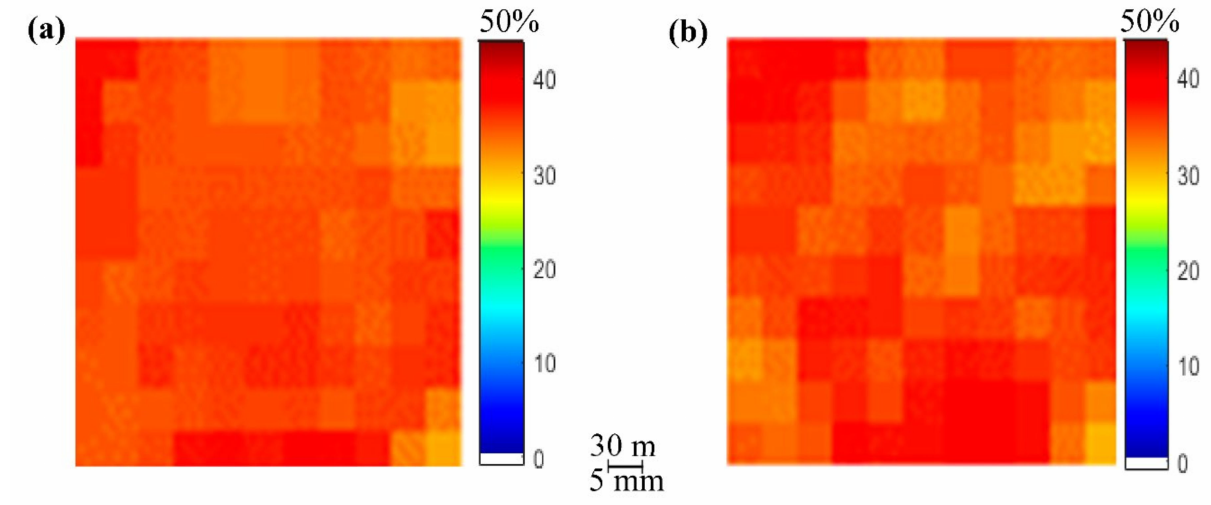
Figure 9. SMC maps: ( a ) produced by the estimation using the weight-based methodology and ( b ) produced by field measurements (17 November